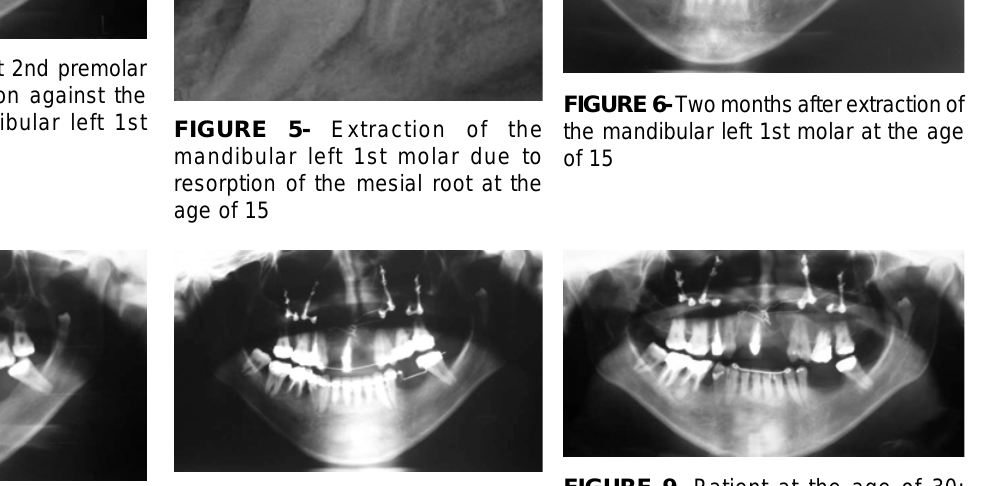
FIGURE 8- Patient at the age of 23: mandibular left 2nd premolar located in the mandibular notch